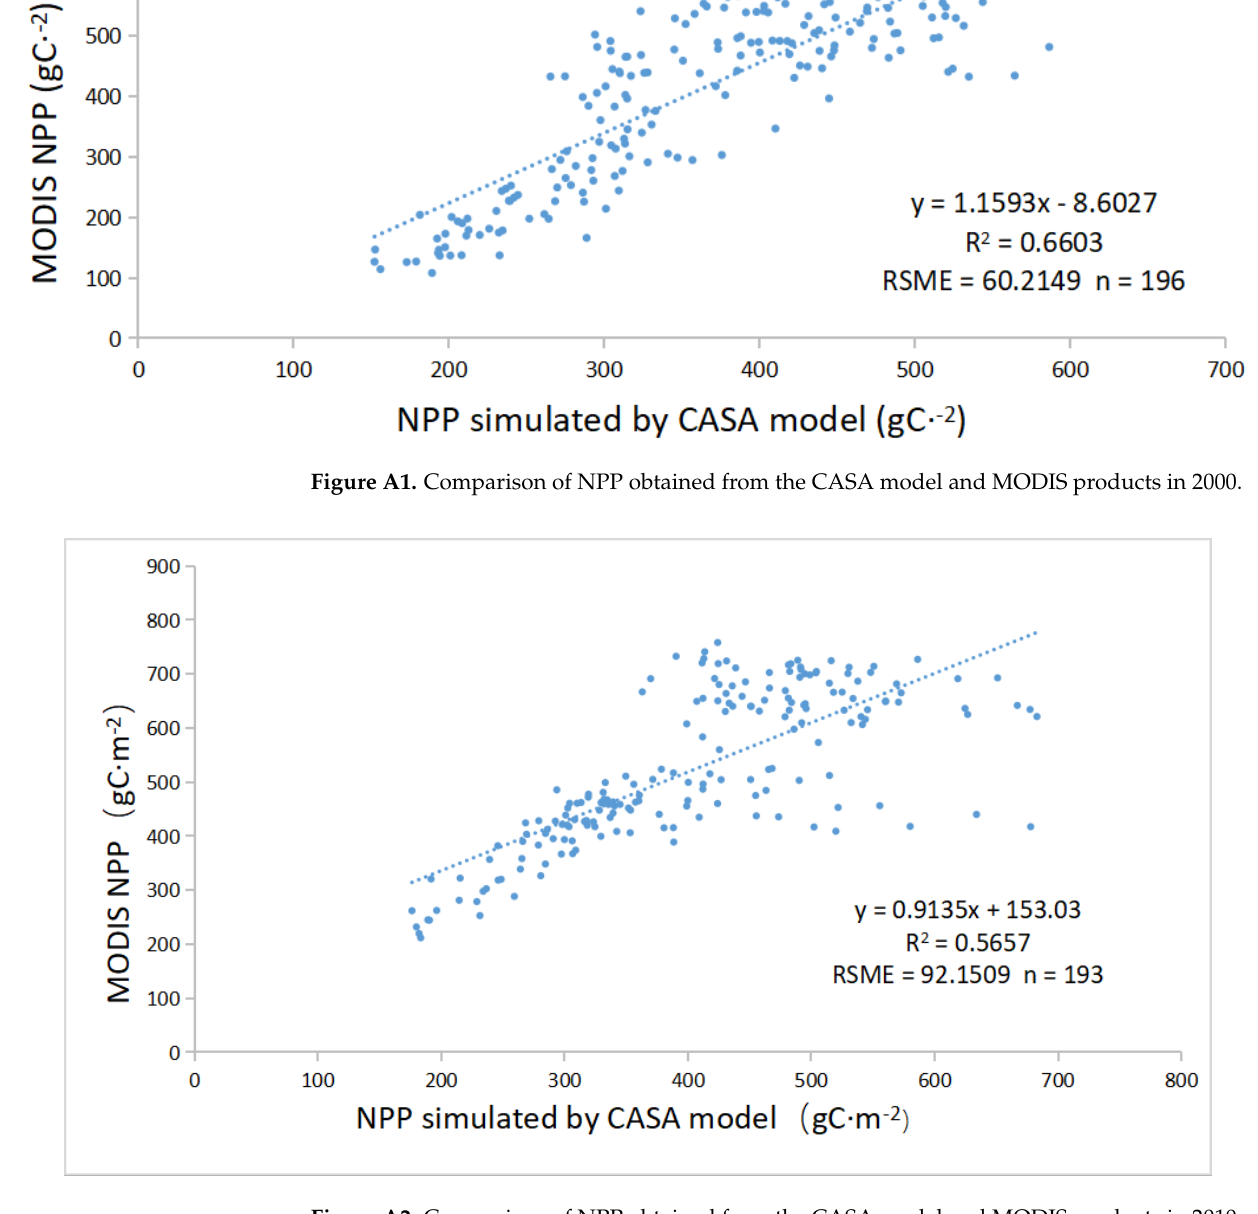
Figure A3. Comparison of NPP obtained from the CASA model and MODIS products in 2018. Table A4. Verification results of FVC in 2000. Window Number